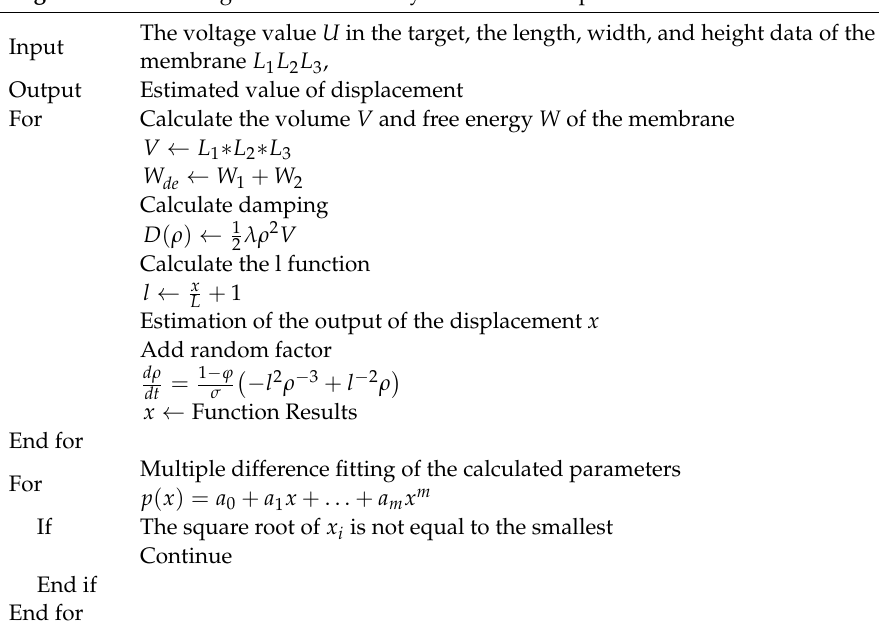
Algorithm 1: IFEA algorithm based on cyclic domain